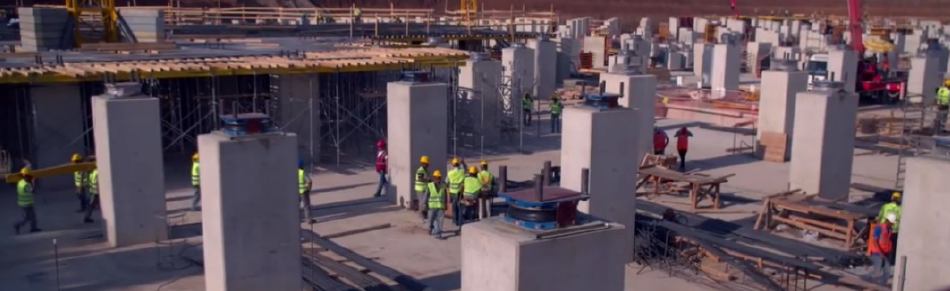
Figure 34. Installation of multi-surface curved surface friction sliders (TFP) for Adana City Hospital (Courtesy of Rönesans Construction Inc., Adana,Turkey).